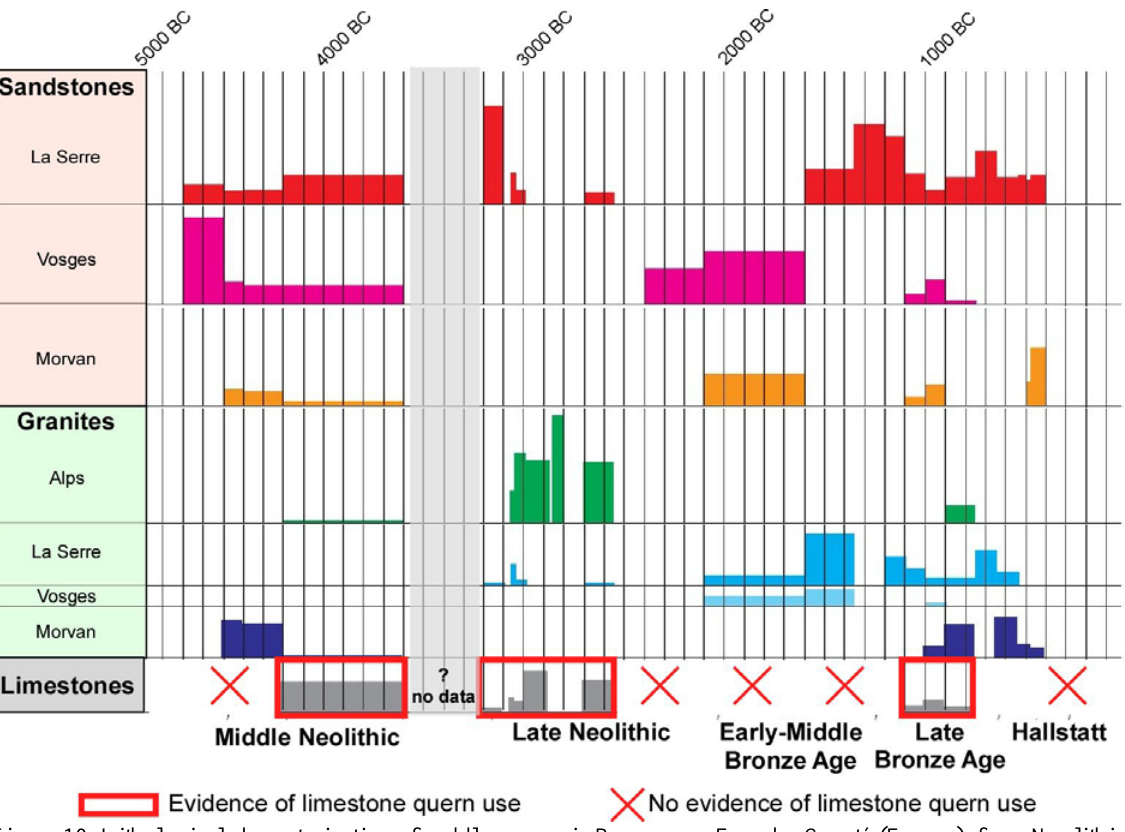
Figure 10. Lithological characterization of saddle querns in Bourgogne-Franche-Comté (France), from Neolithic to Early Iron Age (from Jaccottey & Milleville